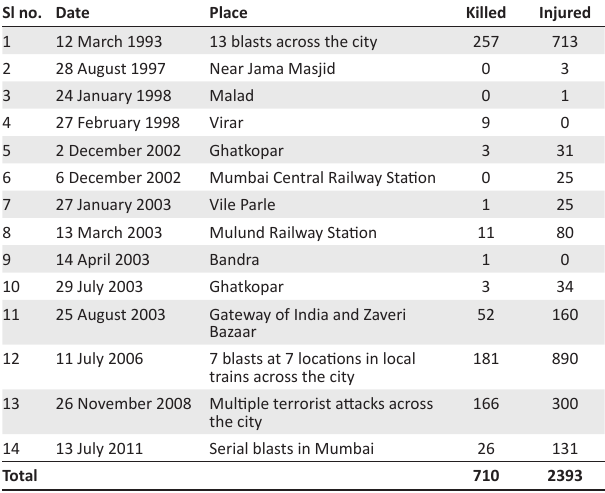
TABLE 1: Number of casualties and mortalities in terror attacks in Mumbai over the last two decades.